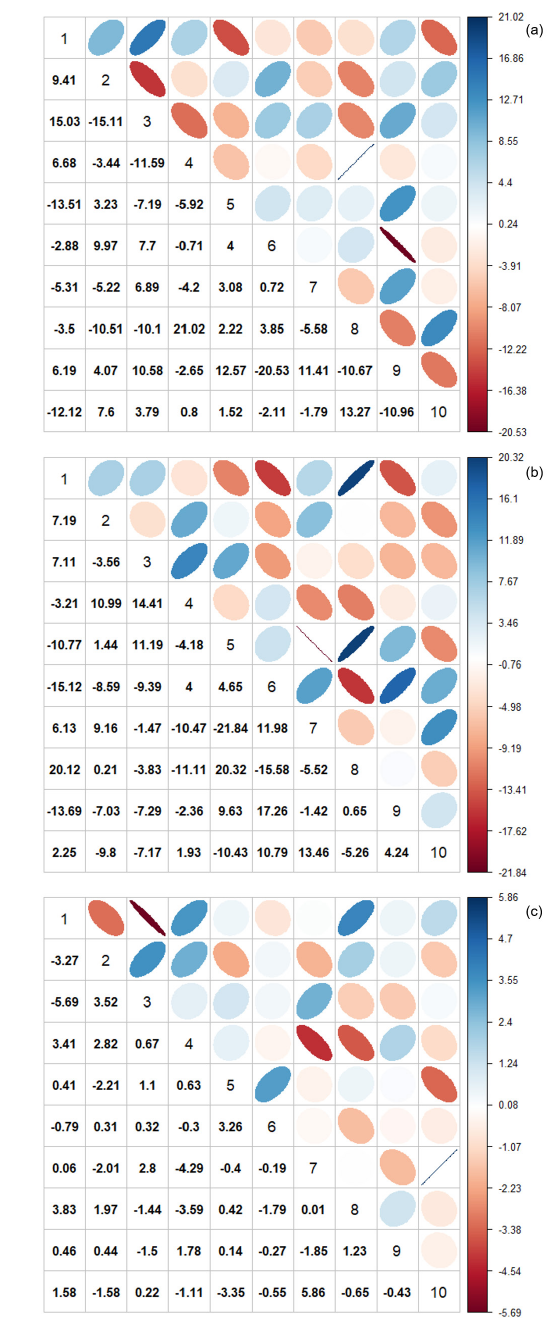
Figure 3. Specific combining ability for mega-trait 2 (tassel size) of 90 crosses conducted in Frederico Westphalen (a), Pato Branco (b) and Campos Novos